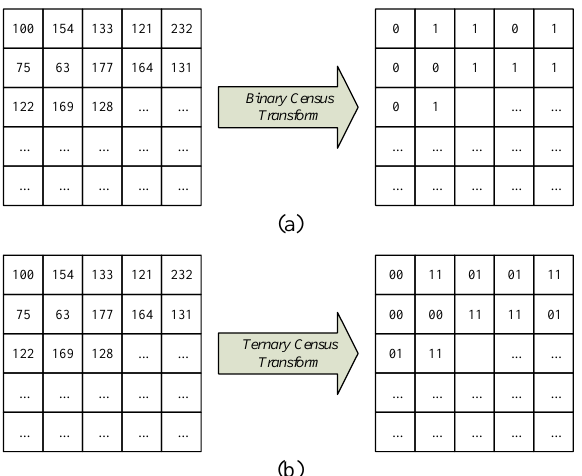
Figure 2. Illustration of census transform on a 5  5 grid; (a) Binary census transform and (b) ternary census transform.